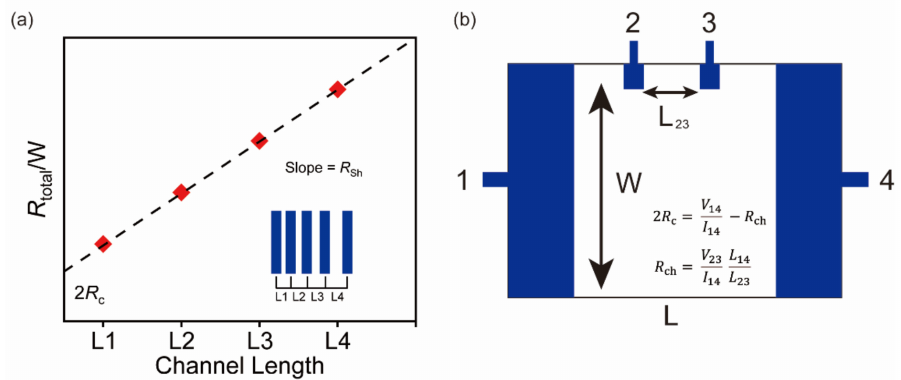
Figure 8. Methods to extract contact resistance. ( a ) Schematic of transfer length method. ( b ) Schematic of four-point probe